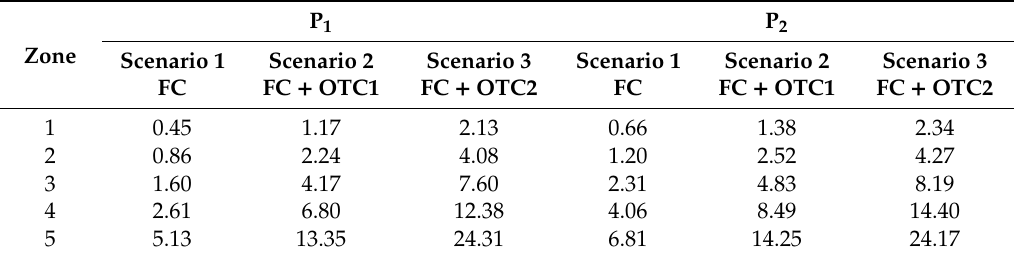
Table 8. Initial demand function points for the MTNP (P 1 and P 2 ).